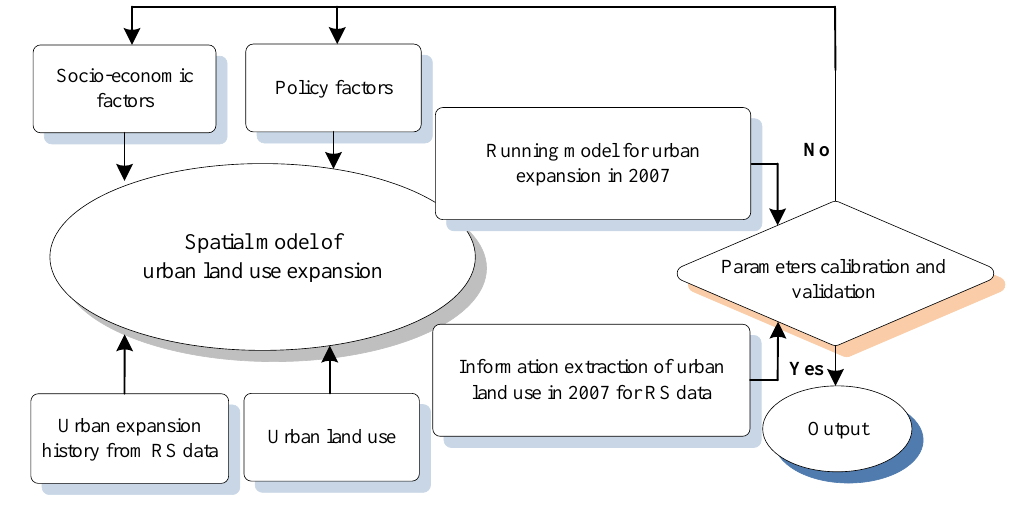
Figure 2. Model simulation and validation.